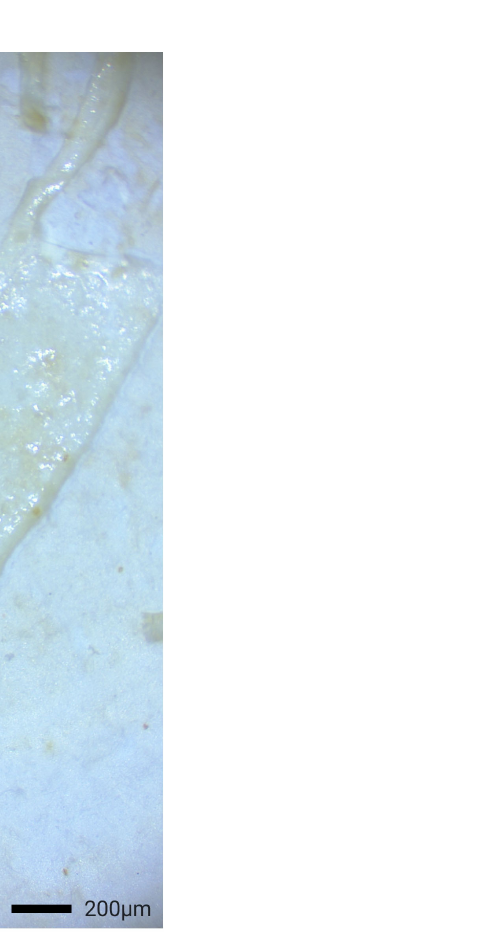
FIGURE 3 Example of Transparent Film from a Gastric Sample of a Bottlenose Dolphin Sampled in Sarasota Bay, Florida